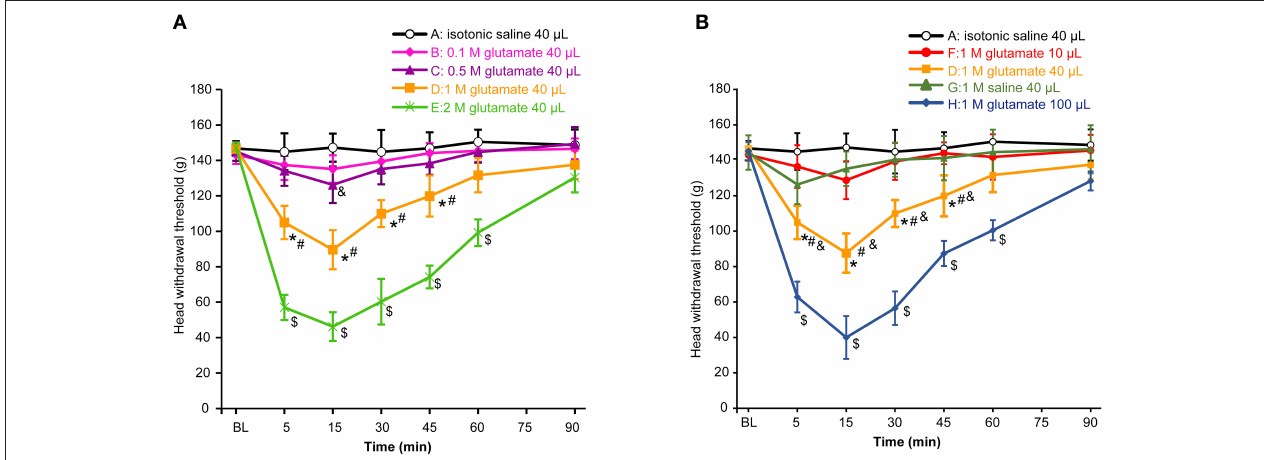
FIGURE 1 | Glutamate evoked hypernociception of the masseter muscle. (A) The concentration-dependent effects of glutamate on hypernociception of the masseter muscle. The volume of glutamate injected into masseter muscle was 40 µ L in each group. * P < 0.05, comparison between group D and A; # P < 0.05, comparison between group D and C; $ P < 0.05, comparison between group E and D; & P < 0.05, comparison between group C and A at 15min post-injection; (B) The volume-dependent effects of glutamate on hypernociception of the masseter muscle. * P < 0.05, comparison between group D and A; # P < 0.05, comparison between group D and G; & P < 0.05, comparison between group D and F; $ P < 0.05, comparison between group H and D; n = 6, BL,